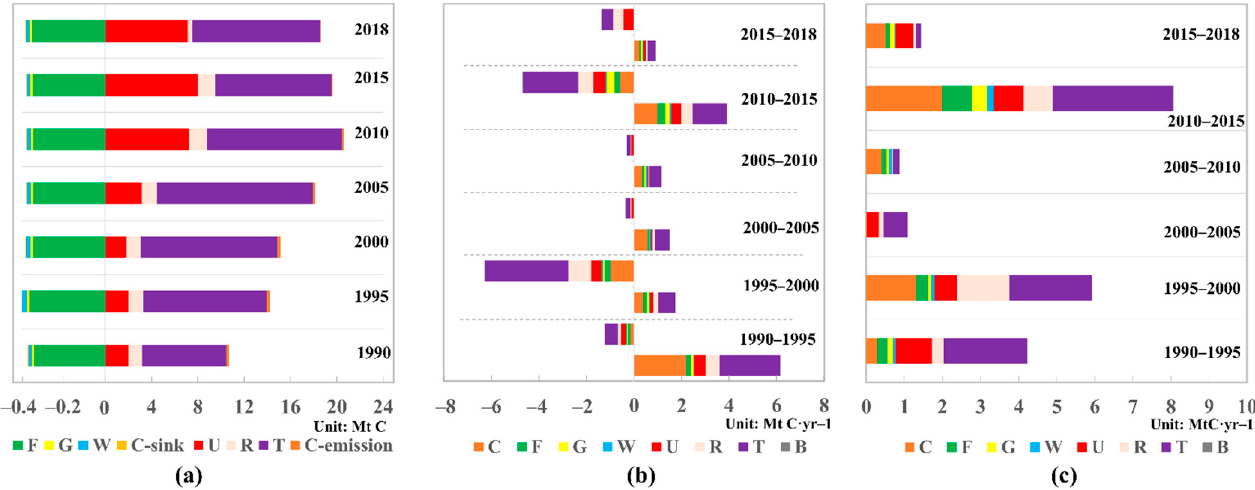
Figure 2. ( a ) Carbon emission and sequestration in each year. Direct ( b ) and integrated ( c ) carbon flows through the network in each period. Note: F, forest; G, grassland; W, bodies of water; U, urban land; R, rural land; T, transportation and industrial land; B, bare land; C, cultivated land; C-emission, carbon emission from cultivated land; C-sink, carbon sequestration produced by cultivated